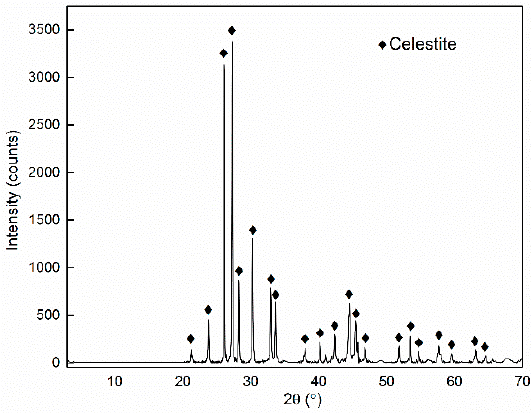
ff raction (XRD) pattern of the celestite Figure 1. The X-ray diffraction (XRD) pattern of the celestite sample. Figure 1. The X-ray di